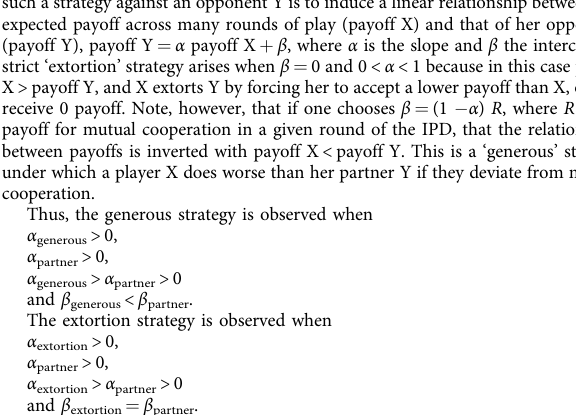
Figure 1a. We tested whether the player had used the extortion strategy, who managed to earn at least 10% more than the partner and who ’ s partner had not earned less in the block in which he had cooperated most (the latter would not occur when playing against an extortionate player). Their behaviour is shown in Fig. 2b, c and the behaviour of the unselected players is shown in Supplementary Figure 1b, c. For this statistical analysis we used the average payoff and the average cooperation of the 10 rounds of each period (9 rounds for the last period). So for each individual we had fi ve data points for the payoff and the cooperation, respectively. We ran treatment-speci fi c tests where we added pair (prisoners dilemma pair) nested within group (experimental group) as random effect to all models (e.g., payoff ~ cooperation rate partner × players + (1| group/pair). Statistical tests were performed in R (R Core Team 24 ) using the lmerTest package 25 . R 2 were calculated using the r.squaredGLMM function of the MuMIn package 26 . We used treatment-speci fi c generalised linear models (GLMs) with family Gamma (link = 'log') for the correlations between payoffs of the ZD player and the other player (Fig. 3). We used the Gamma family as data were non-normal distributed (shaprio.test: W = 0.98688, p = 0.0002) and positively bound. We used also GLMs with family Gamma (link = 'log') for the comparisons of the probability to cooperate, the proportion of DD decisions (i.e. both players decided D),